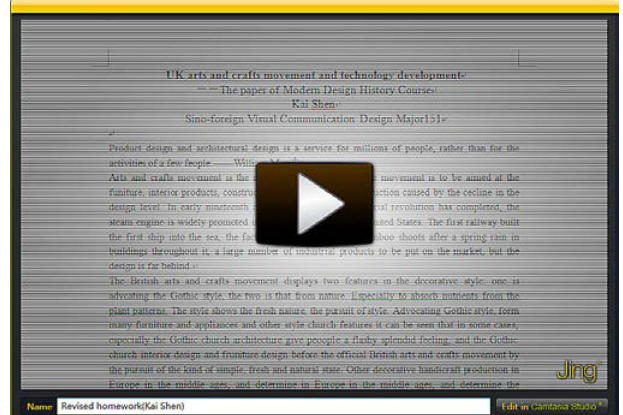
Figure 3. The online homework checking